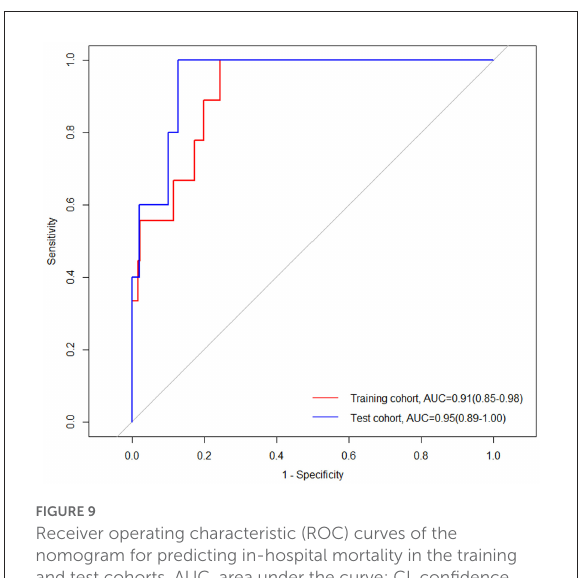
FIGURE9 Receiver operating characteristic (ROC) curves of the nomogram for predicting in-hospital mortality in the training and test cohorts. AUC, area under the curve; CI, confidence